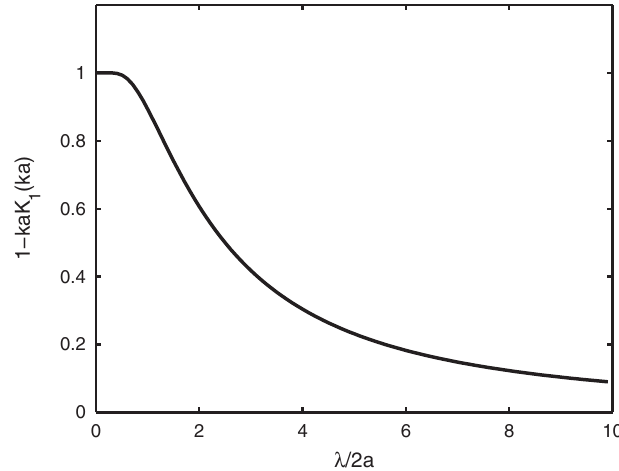
FIG. 5. Factor 1 (cid:3) ka (cid:4) K 1 ð ka Þ as a function of the wavelength normalized to the beam diameter, 2 a